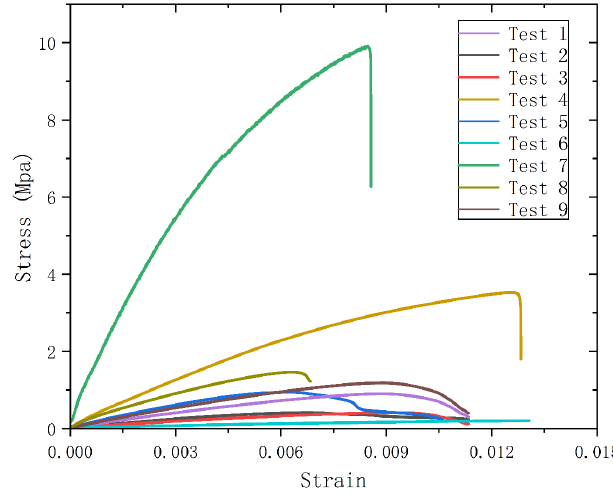
Figure 9. Stress versus strain curve.